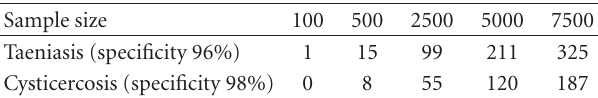
Table 1: Upper limit ( U ) of positive tests allowed for 99% confi- dence that the prevalence is less than the target limit of 1%. Sensitivity of the tests is assumed equal to